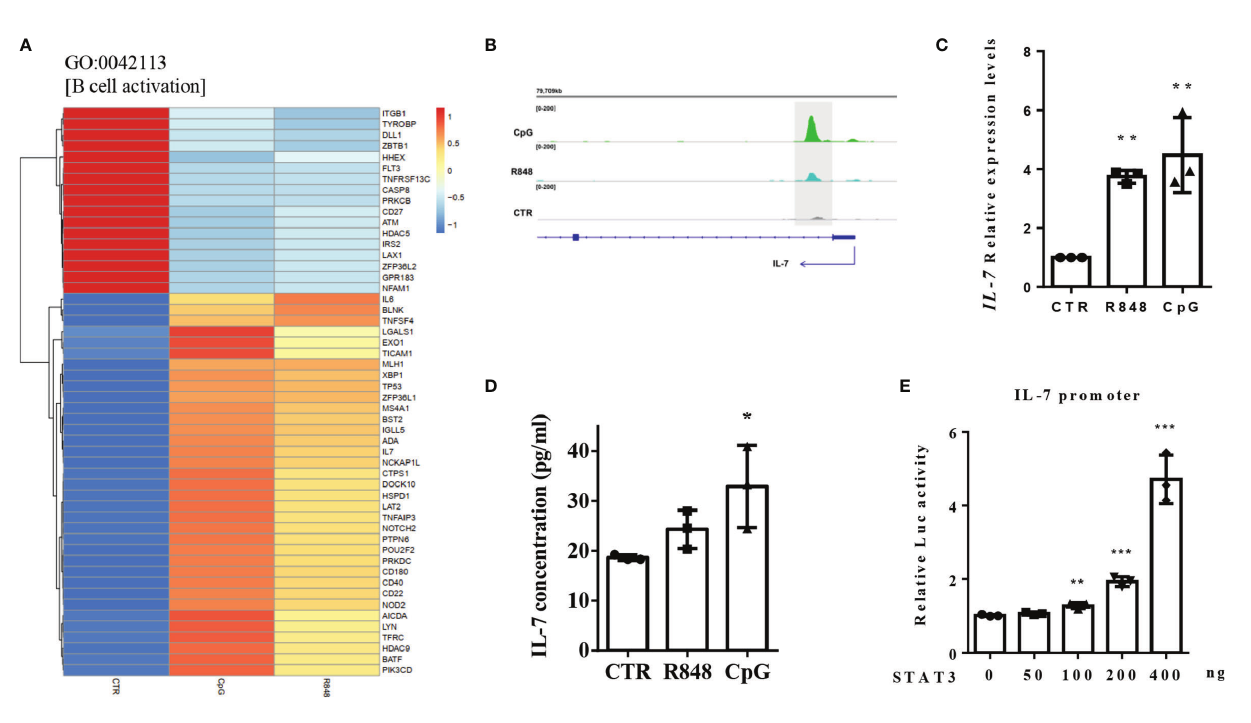
FIGURE 7 | STAT3 regulated IL-7 expression by directly binding to its promoter. (A) Heatmap showing the TLRs-regulated genes in the biological progress (GO) term “ B cell activation ” . (B) STAT3 binds to IL-7 gene promoter in TLR7/9 agonists activated human peripheral blood B cells. (C) RT-qPCR was used to detect IL-7 expression in B cells in response to R848 and CpG stimulation. (D) Elisa assay was used to detect the concentrations of IL-7 in the supernatant of unstimulated (CTR), R848-stimulated and CpG-stimulated B cells. The data are presented as the mean ± standard deviation (SD) (n = 3). (E) Luciferase reporter assay was used to detect the effect of STAT3 on the luciferase activity of IL-7 gene promoter. Three independent experiments were performed, and data are shown as mean ± SD. *P < 0.05, **P < 0.01, and ***P <